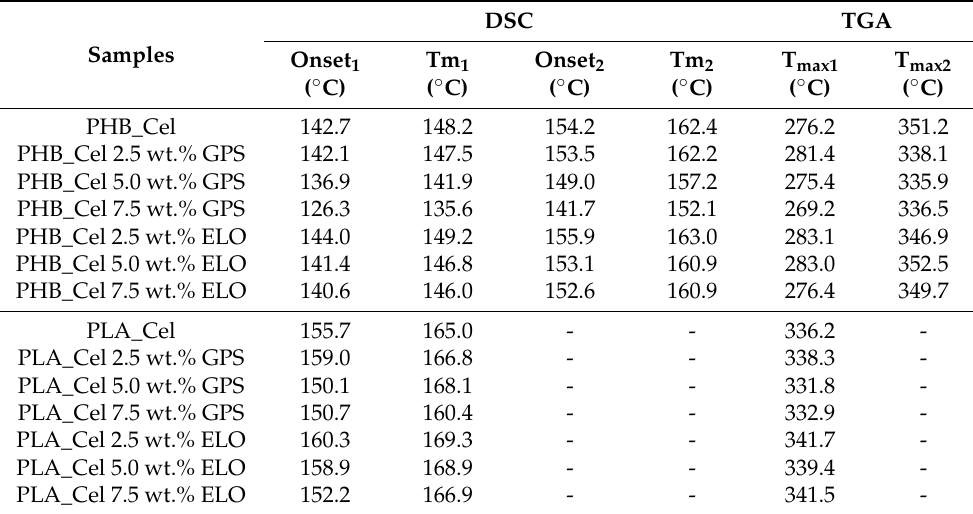
Table 2. DSC and TGA data of the PHB- and PLA-based composites without additives and with different loads of GPS and ELO